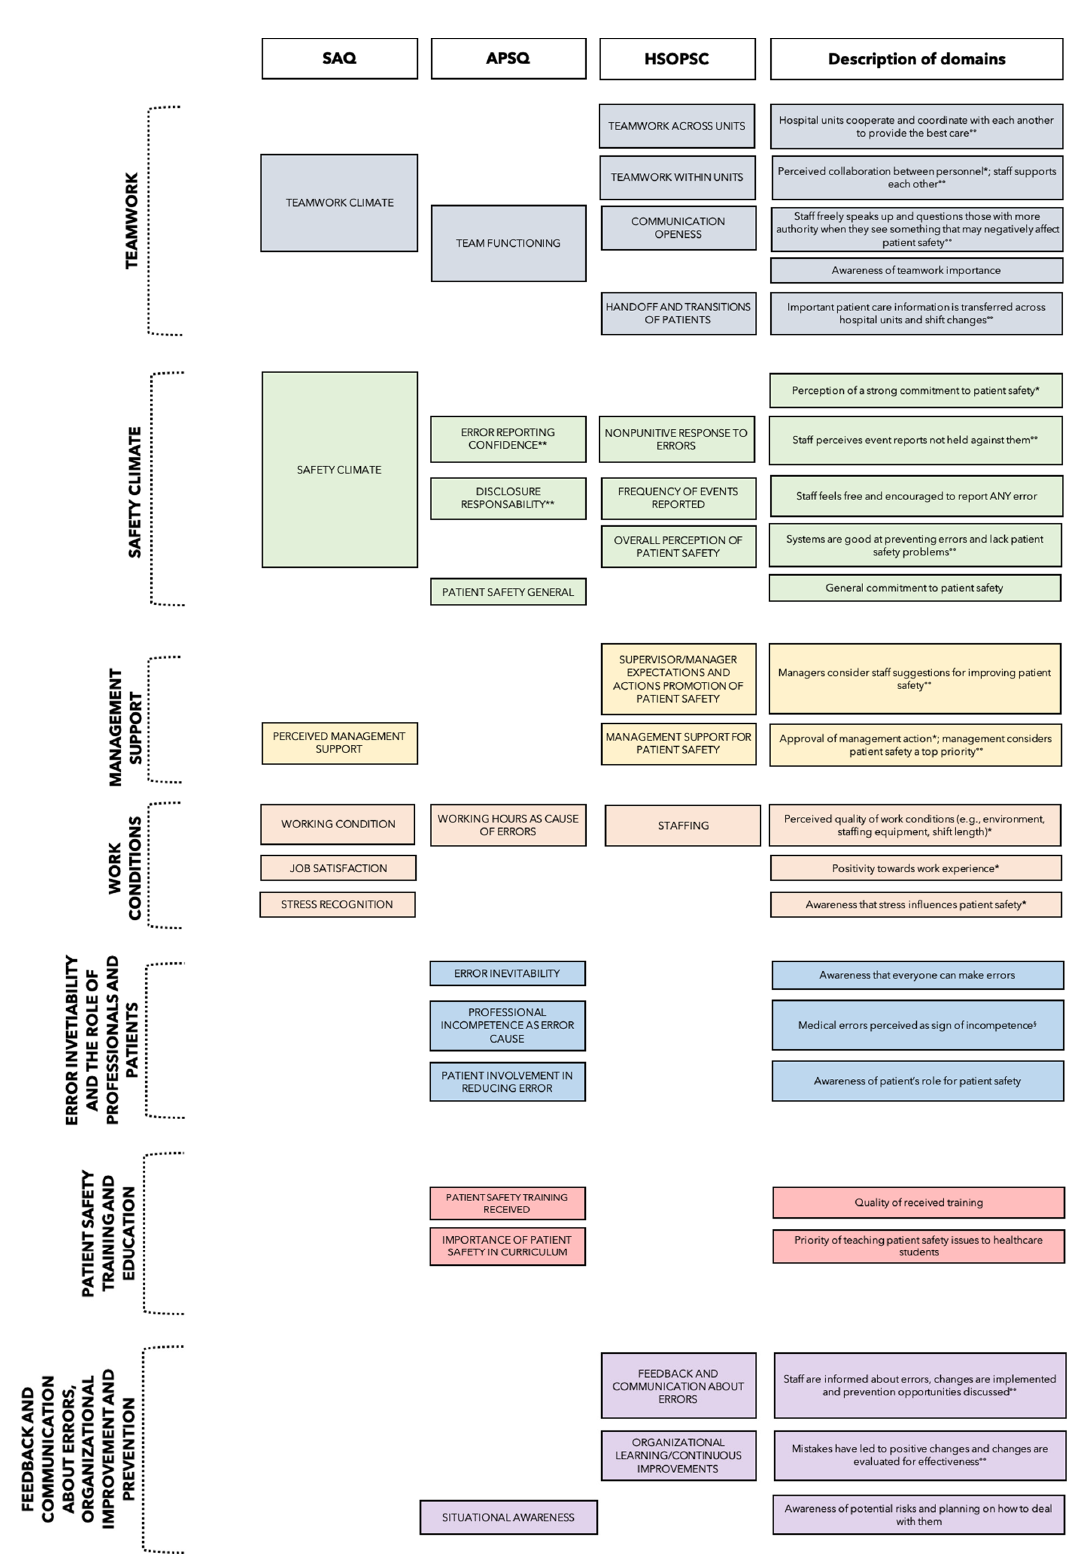
Figure 2. Overview of the domains of the most applied questionnaires, validated in their original language (SAQ, APSQ, HSOPSC). Notes. ** the dimension safety climate includes items regarding “error reporting confidence” and “disclosure responsibility”; § all items reversed (reversed dimension); * Adapted from Sexton et al. [51], ◦◦ Adapted from Sorra et al. [52].